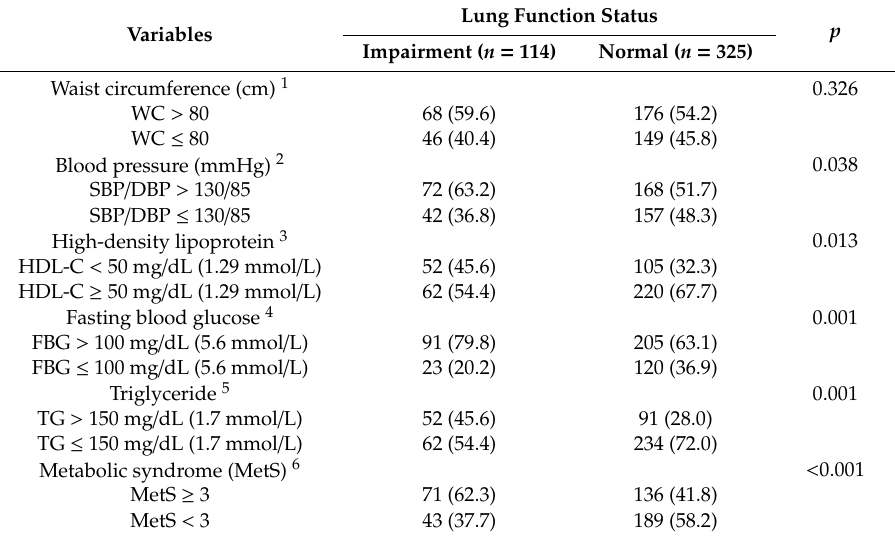
Table 2. Cardiometabolic Risk Factors Associated with Lung Function Impairment (N =